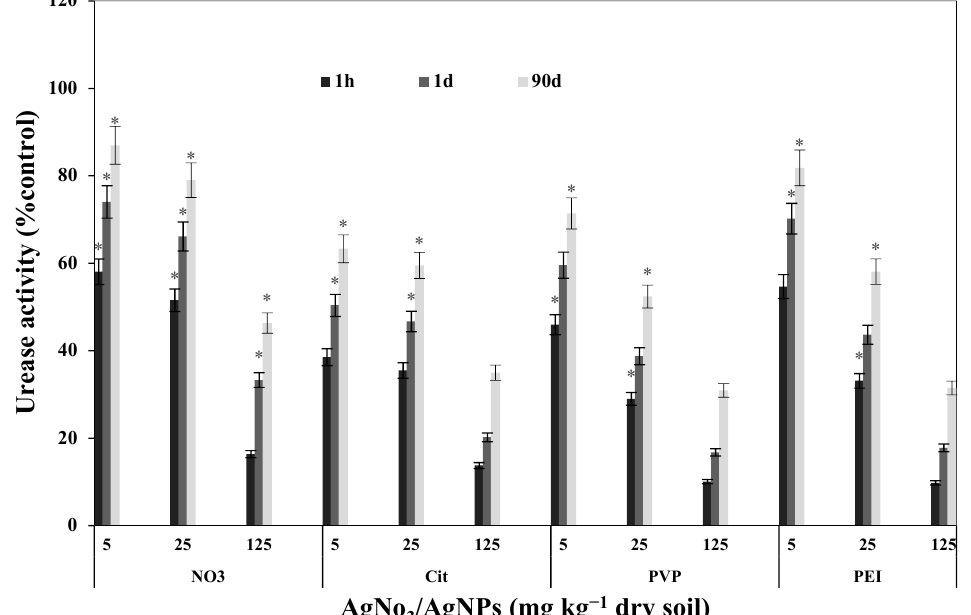
Figure 2. Activities of urease as a percentage of the mean of the control (no Ag/AgNPs added) treatments exposed to 5, 25, 125 mg AgNO 3 /AgNPs (Cit, PVP, PEI coated) kg − 1 dry soil after 1 h, 1 d and 90 d. Values are the means of three replicates ± standard deviation. The asterisk (*) denotes significant differences with the control ( p < 0.05).